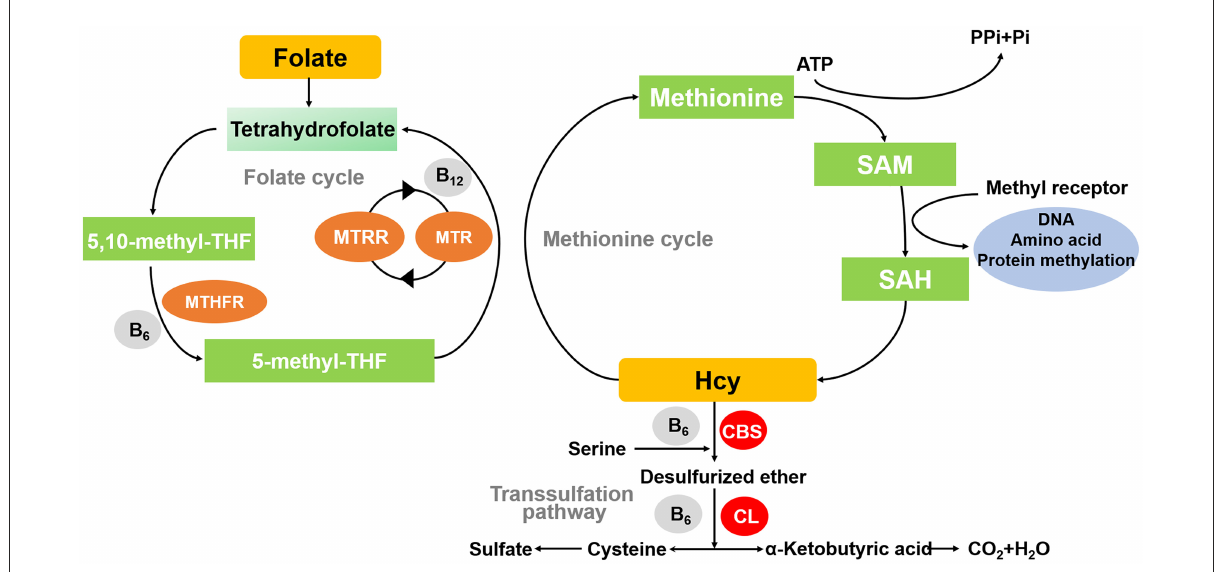
FIGURE1 Diagram of methionine cycle. MTHFR, methylene tetrahydrofolate reductase; MTR, 5-methylthioribose; MTRR, Methionine synthase reductase; CBS, Cystathione- β -synthase; CL, Cystathione- β -cleavage enzyme; SAH, S-adenosyl-homocysteine; SAM, S-adenosyl